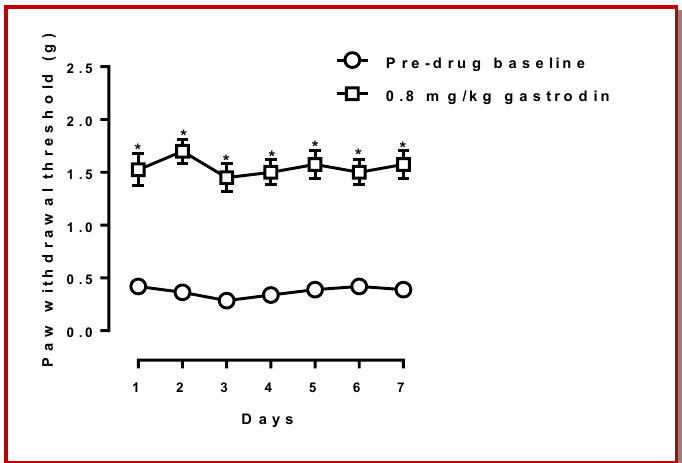
Figure 4: Anti-hyperalgesic effect of daily 0.8 mg/kg gastrodin treatment in mice (n = 8 per group). *p<0.05 as compared to corre- sponding daily baseline data as measured before vincristine treatment